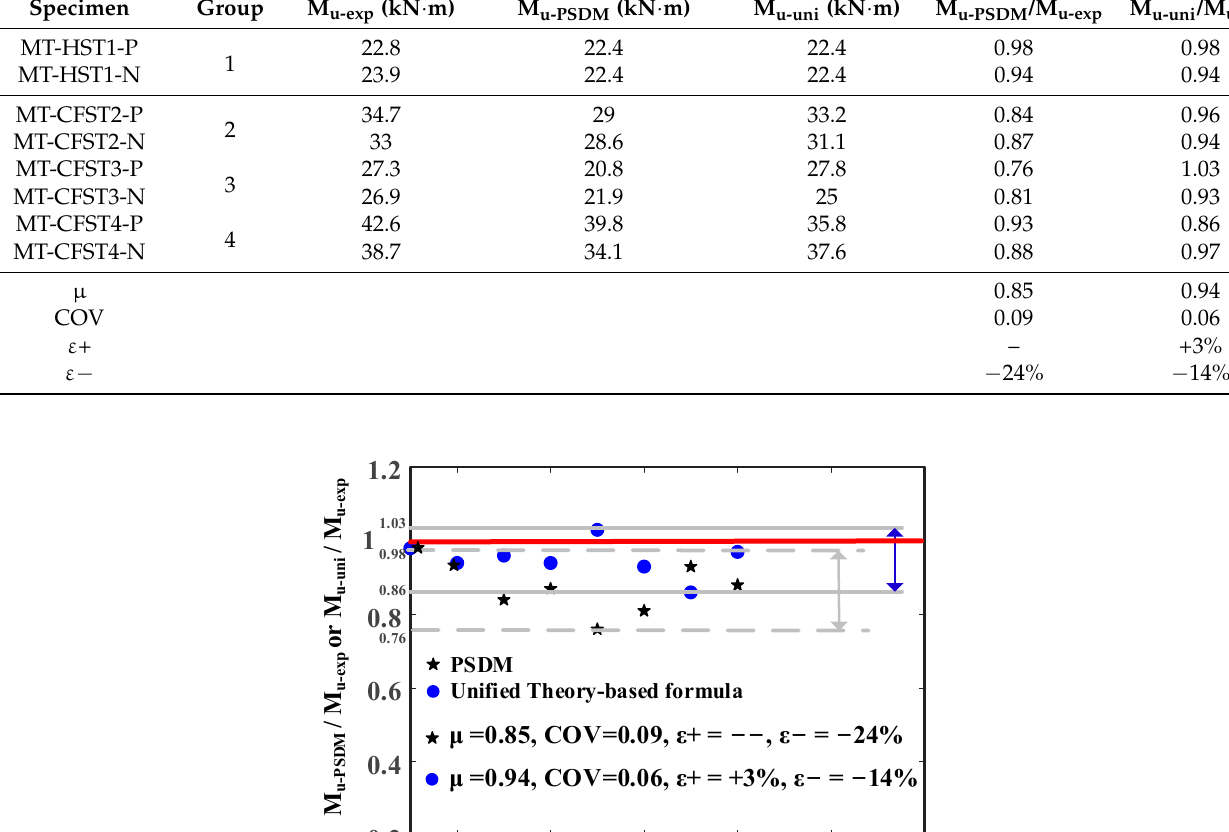
Table 3. Predicted results from PSDM and the Unified Theory-based formula.